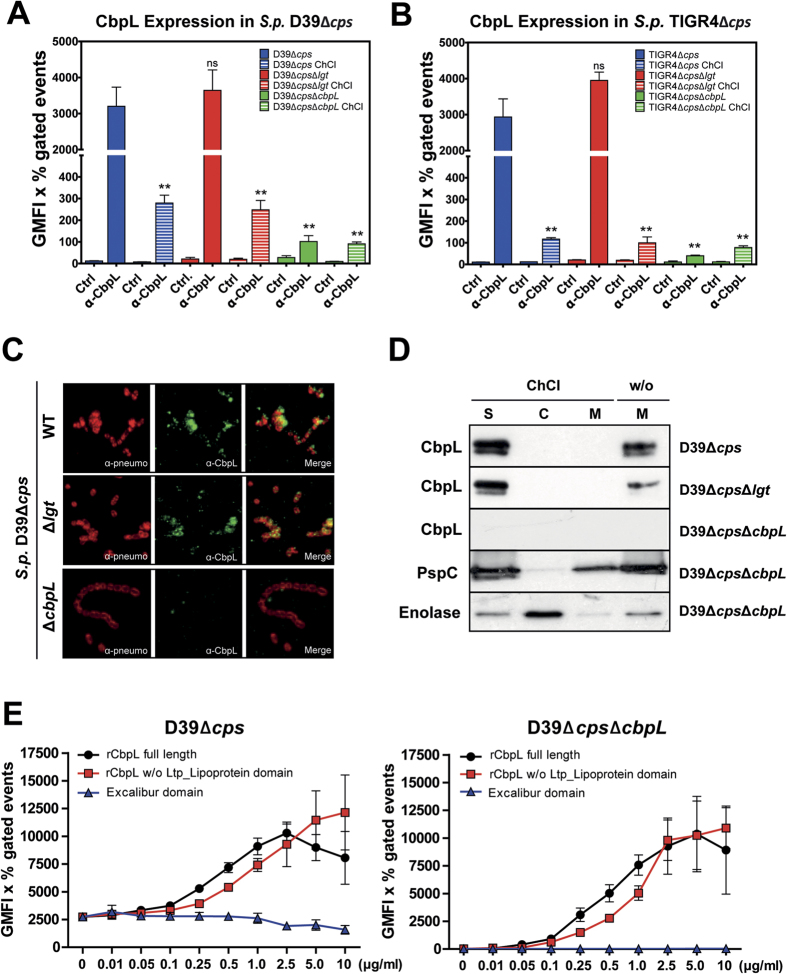
CbpL is a choline-binding protein exposed on the pneumococcal cell surface.(A,B) The surface-exposure of CbpL proven by flow cytometric analysis using polyclonal anti-CbpL antibodies as primary antibodies and secondary goat anti-mouse IgG coupled Alexa-Fluor-488 (Invitrogen). The surface abundance of CbpL was measured without and after ChCl treatment (10% ChCl for 30 min), which generally results in release of CBPs. The bar charts (A,B) demonstrate the increase in fluorescence intensity of the parental strains D39Δcps or TIGR4Δcps compared to the isogenic cbpL-mutants and controls (Ctrl). The lgt-mutants of D39Δcps and TIGR4Δcps showed similar fluorescence intensities compared to the parental strains D39Δcps and TIGR4Δcps, while ChCl treatment significantly reduced anti-CbpL binding, indicative of a loss of binding of CbpL on the surface. Graphs (A,B) show the results (GMFI multiplied with the number of positive events [%]) of three independent experiments ± S.D. *P < 0.05, and **P < 0.01 relative to the parental strains incubated with the 1st and 2nd antibody. Individual histograms and dot plots are depicted in Fig. S4. (C) Immunofluorescence microscopy of D39Δcps, D39ΔcpsΔlgt, D39ΔcpsΔcbpL to show CbpL on the bacterial cell surface. Pneumococci were incubated with rabbit anti-pneumococcal IgG70 followed by secondary goat anti-rabbit IgG coupled Alexa-Fluor-568 (Invitrogen) to stain pneumococci (red fluorescence) and CbpL was detected with polyclonal anti-CbpL antibodies and secondary goat anti-mouse IgG coupled Alexa-Fluor-488. (D) Immunoblot analysis of pneumococcal protein fractions (S: supernatant; C: cytoplasmic; M: cell membrane) enriched prior or post-treatment of pneumococci with choline chloride (ChCl). Protein fractions were separated by SDS-PAGE and after blotting CbpL was detected using anti-CbpL polyclonal antibodies. Choline-binding protein PspC and enolase (cytoplasmic and moonlighting protein) were used as controls and detected with anti-PspC or anti-enolase antibodies7172. (E) Dose-dependent reassociation of various recombinant CbpL peptides measured by flow cytometry post-incubation of CbpL-expressing D39Δcps or CbpL-deficient D39ΔcpsΔcbpL. The graphs, showing the results (GMFI multiplied with the number of positive events [%]) of three independent experiments ± S.D, demonstrate reassociation of CbpL peptides to the pneumococcal cell surface when the CBM is present.